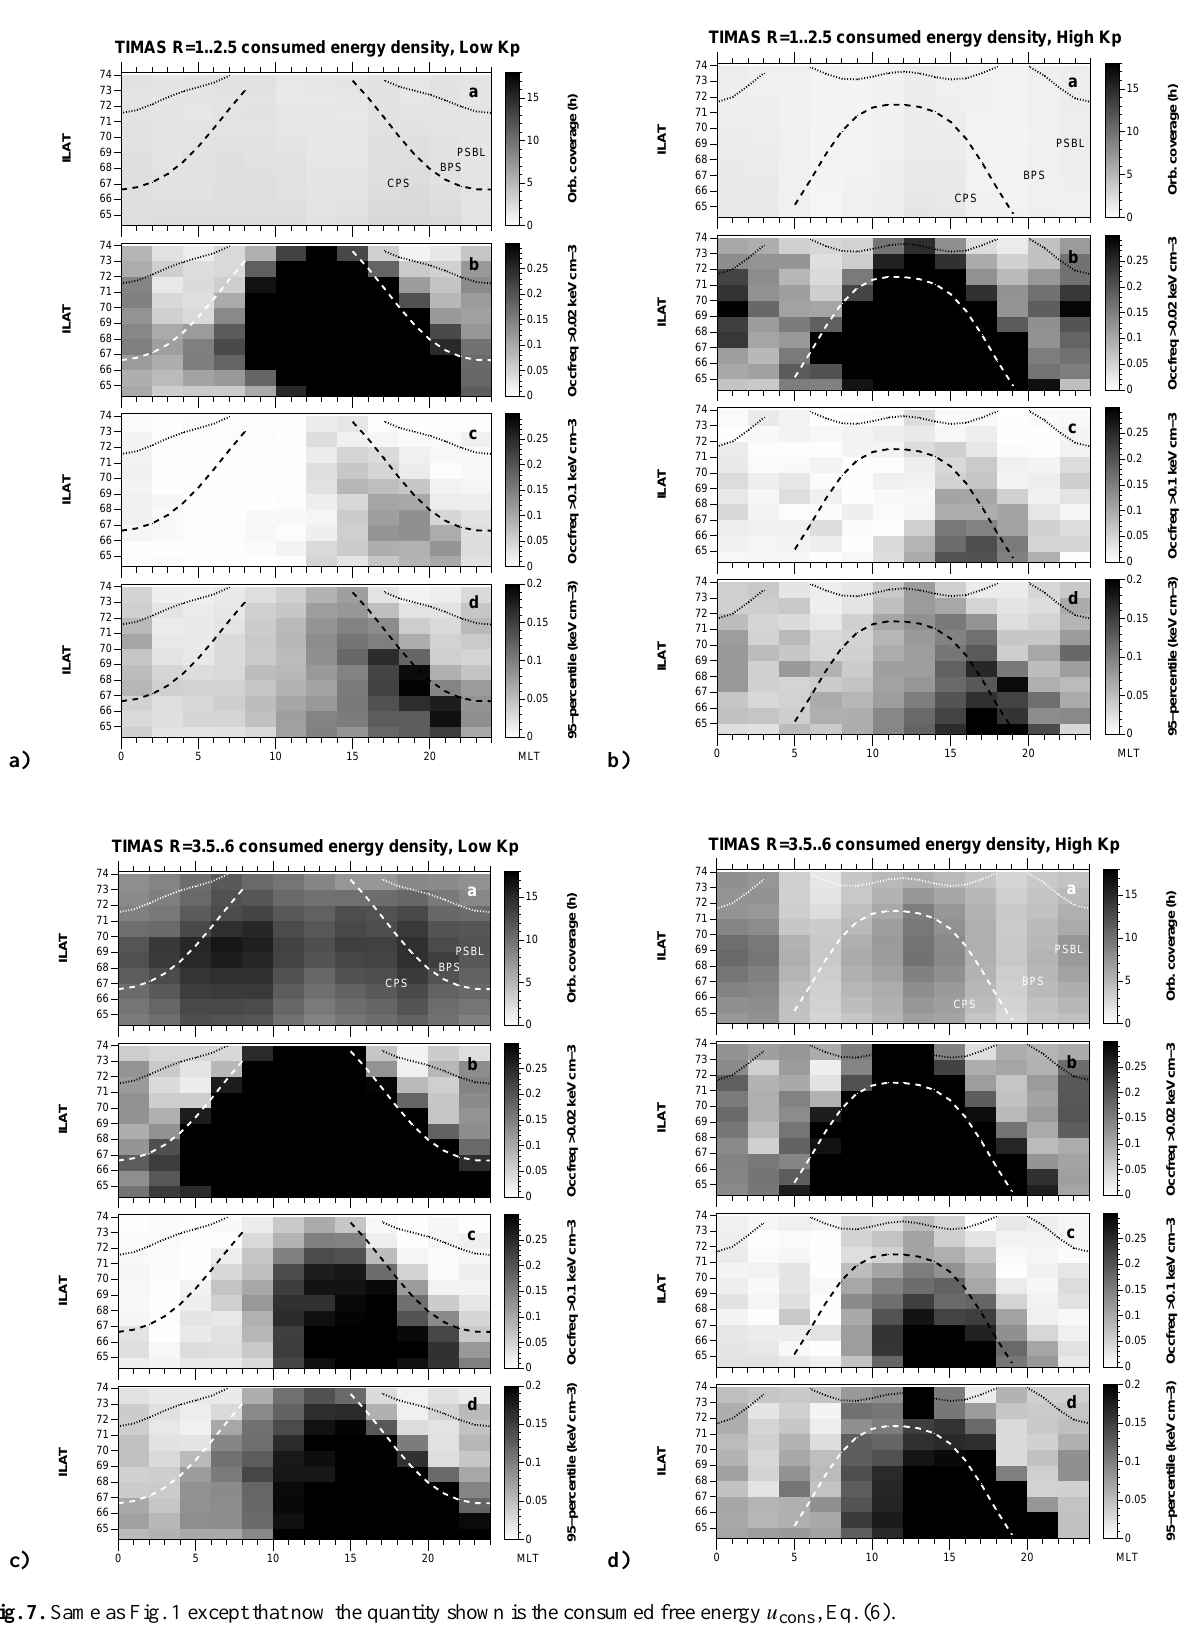
Fig. 7. Same as Fig. 1 except that now the quantity shown is the consumed free energy u cons , Eq.